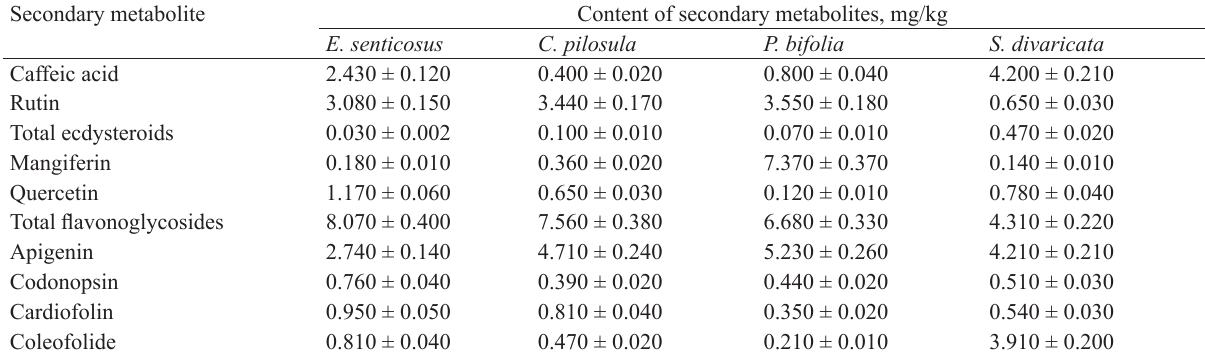
Table 2 Content of secondary metabolites in callus extracts Secondary metabolite Content of secondary metabolites,